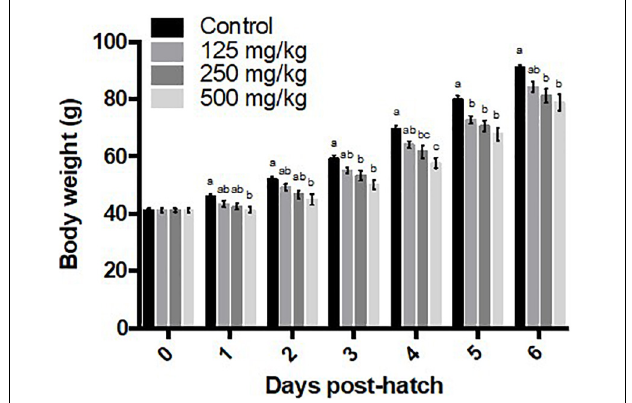
FIGURE 1 | Body weights. Values represent least squares means ± SEM ( n = 12–13). Different superscripts within each day indicate a significant difference at P < 0.05; Tukey’s